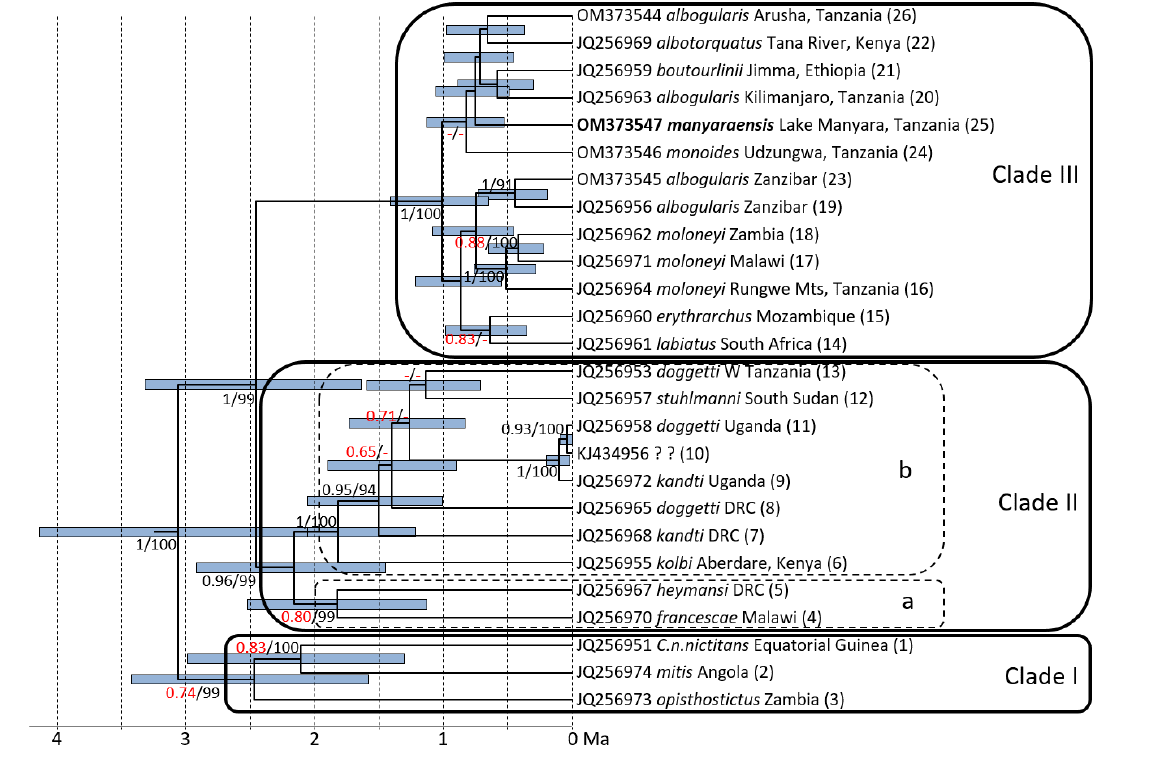
Figure 2. Ultrametric tree based on complete cytochrome b sequences showing phylogenetic relationships and divergence times among mi- tochondrial lineages of gentle monkeys Cercopithecus mitis as inferred from BEAST analysis. Node bars indicate 95% HPDs. The timescale indicates million of years before present (Ma). Node support (ML BS/Bayesian PP) is given at major nodes. Labels indicate GenBank acces- sion number, subspecies label, sampling location, and haplotype number; I–III indicate main mitochondrial clades (see mitochondrial clades, Fig. 3) (DRC: Democratic Republic of